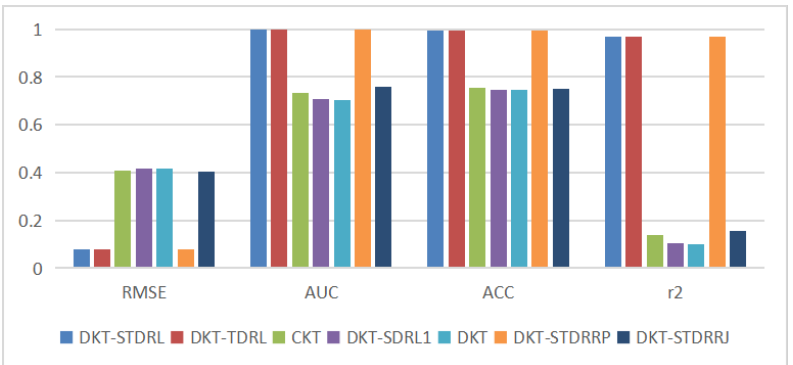
Figure 4. Prediction results of DKT-STDRL, CKT, DKT, and the variants of DKT-STDRL on the ASSISTments2015 dataset.